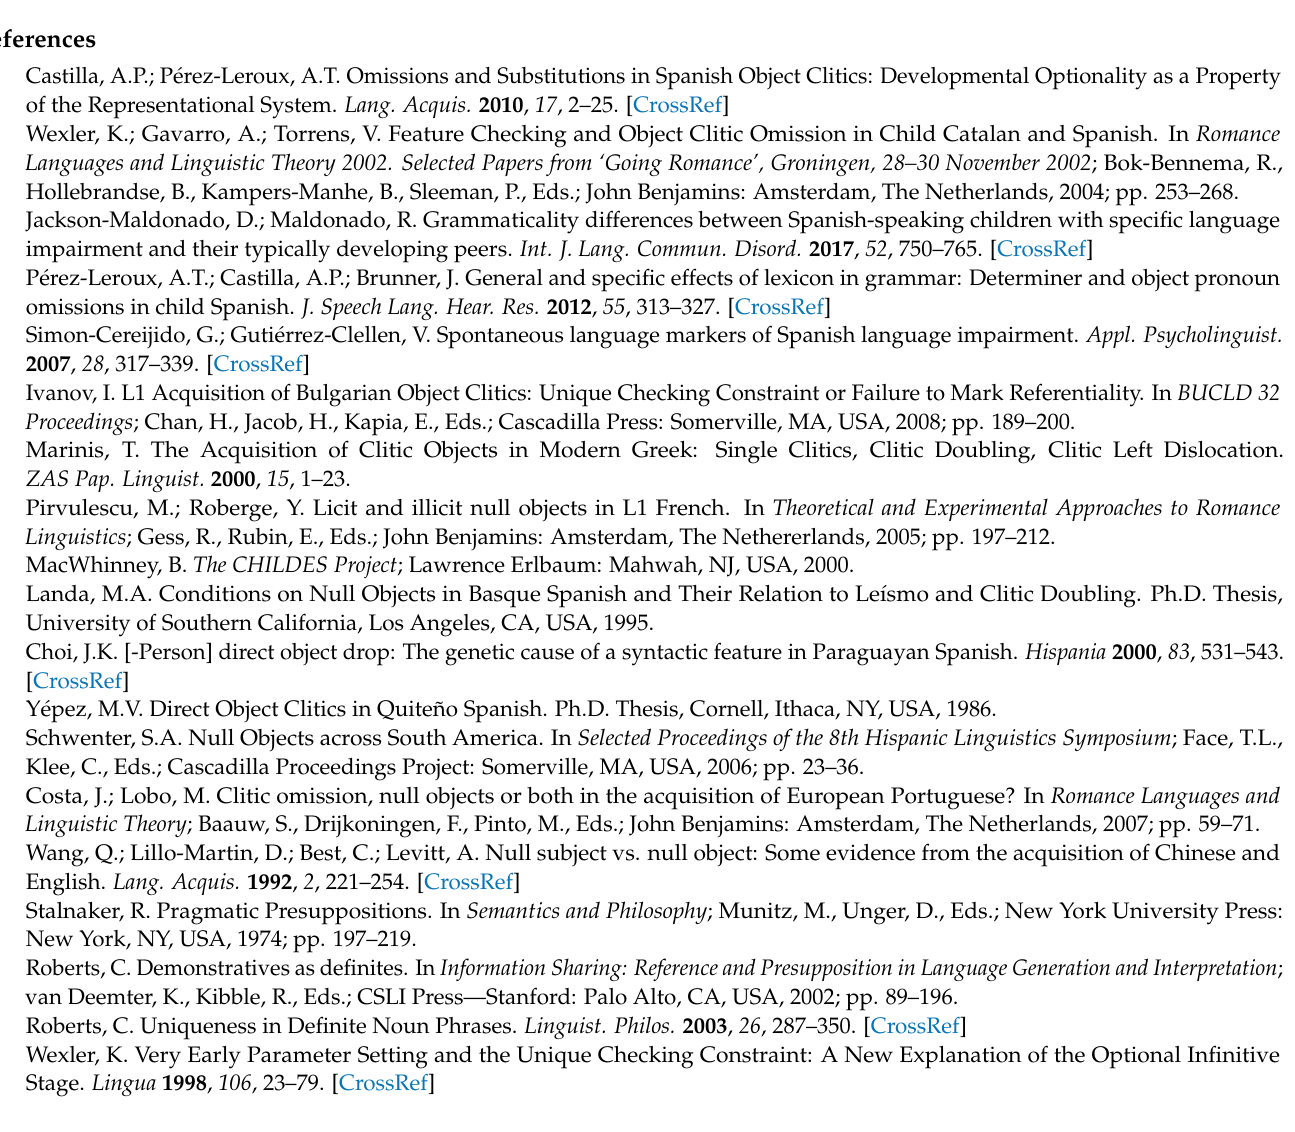
Figure A1. Examples of stimuli used.